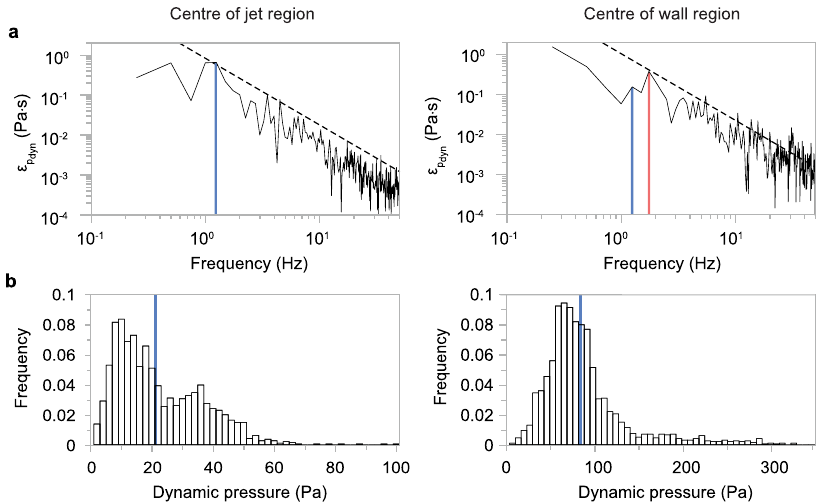
Fig. 7 Turbulent excursions and focussing of dynamic pressure energy into large-scale coherent structures. a energy spectra of dynamic pressure ε P energy cascade. The energy spectra are cut off at 50 Hz. The frequencies of the two energy peaks at 1.25 Hz (blue line) and 1.75 Hz (red line) are highlighted. The 1.25 Hz peak, forming the energy maximum in the jet region and the second highest energy peak in the wall region, is associated with the largest coherent turbulence structures in the experimental pyroclastic surge. The 1.75 Hz peak, forming the energy maximum in the wall region, is related to internal gravity waves that propagate as pulses through the advancing current (Fig. 5). b histograms of probability density functions of dynamic pressure in the centres of the jet (left) and wall regions (right). Maximum values in dynamic pressure, which are associated with the largest coherent turbulence structures and internal gravity waves, exceed mean values of dynamic pressures, which are shown as blue vertical lines by a factor of around three to fi